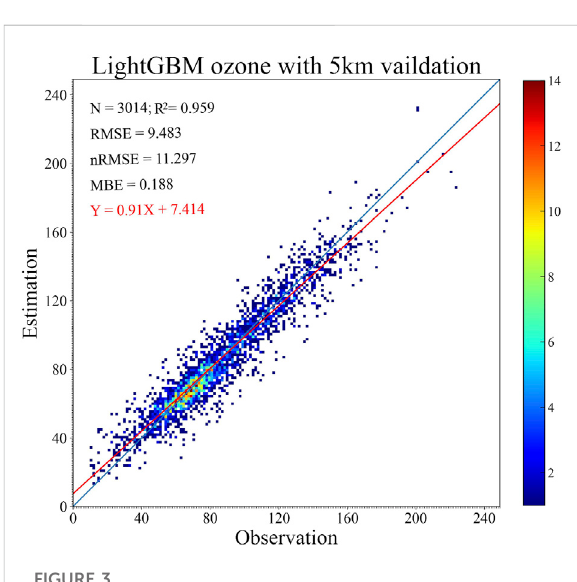
FIGURE 3 Estimatedvalueandgroundstationcross-validationresultsof surface-level O 3